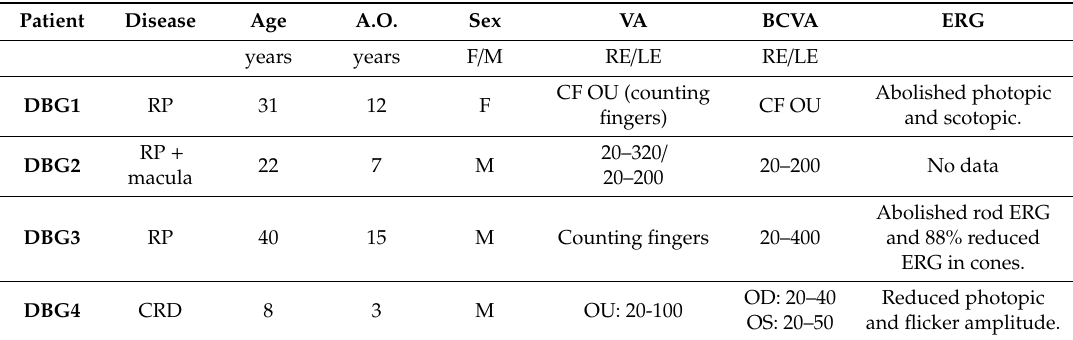
Table 1. Clinical